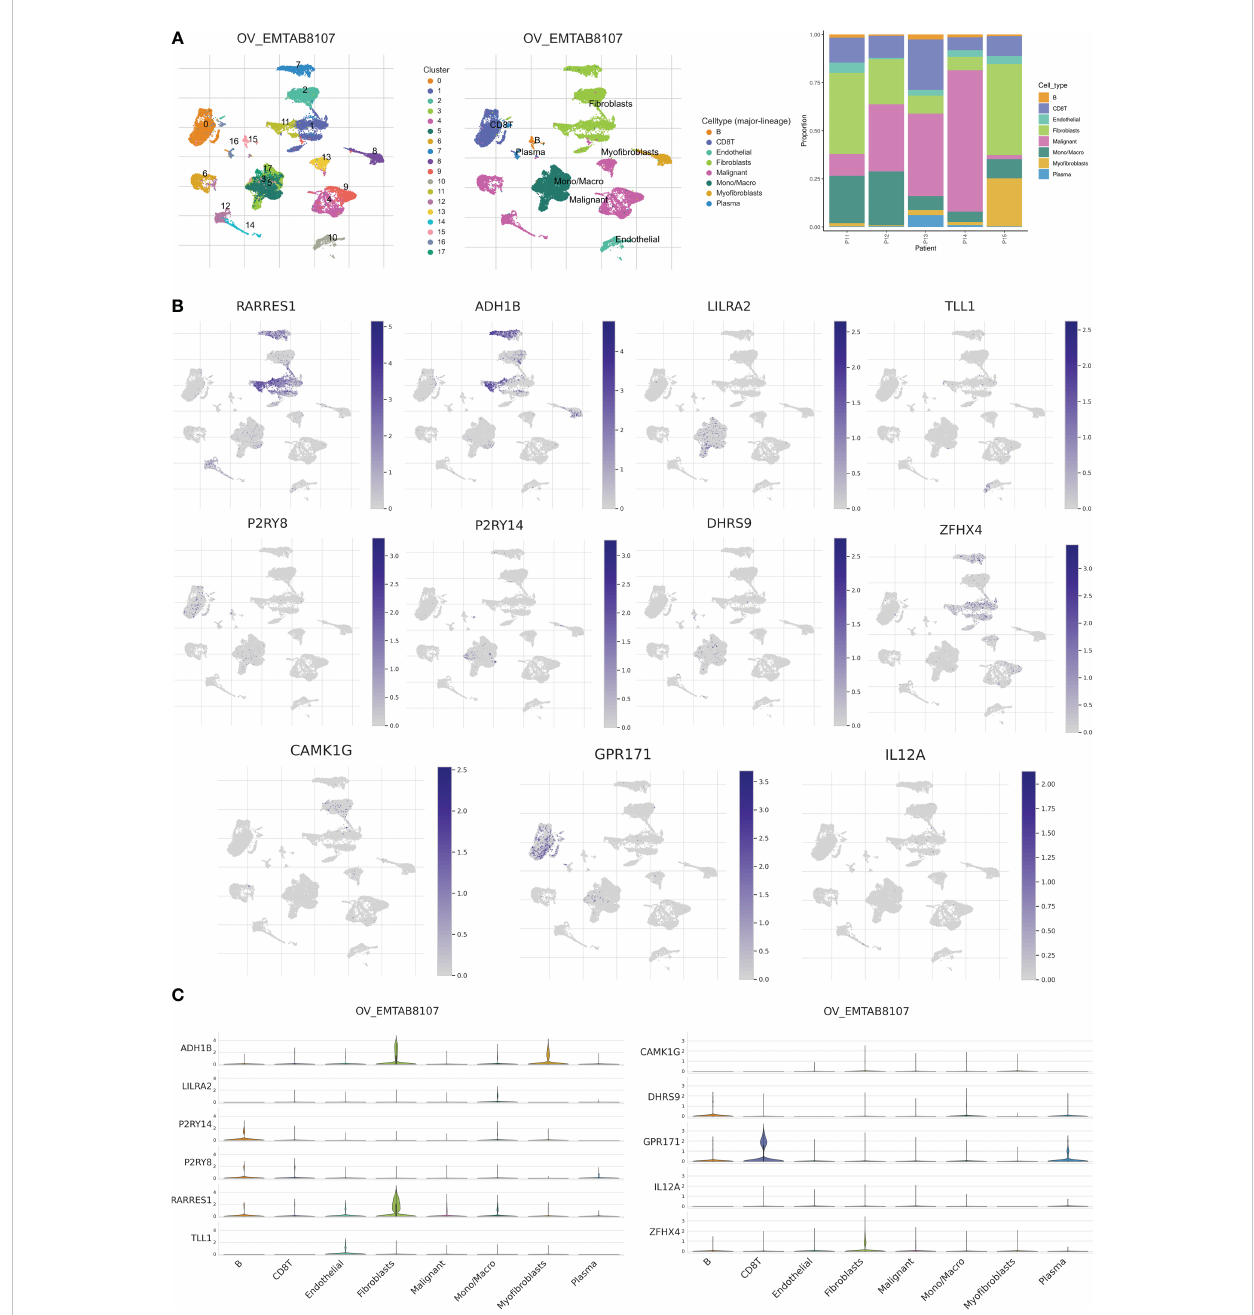
FIGURE 11 Validation of single-cell RNA sequencing. (A) Annotation of all cell types in EMTAB8107 and percentage of each cell type. (B, C) Expression of RARRES1, ADH1B, LILRA2, TLL1, P2RY8, P2RY14, DHRS9, ZFHX4, CAMK1G, GPR171 and IL12A in each cell